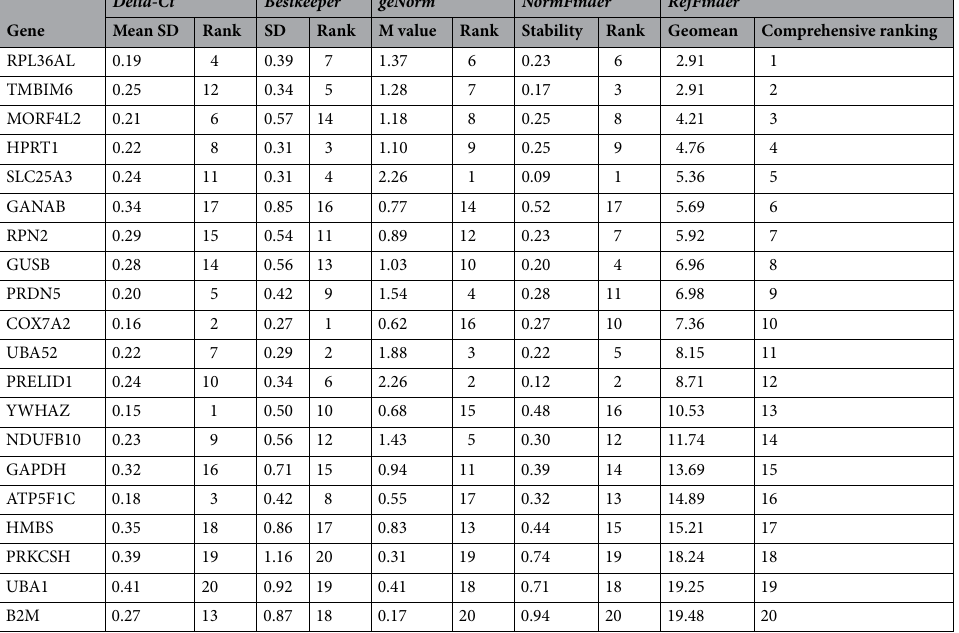
Table 3. Housekeeping gene ranking of all five